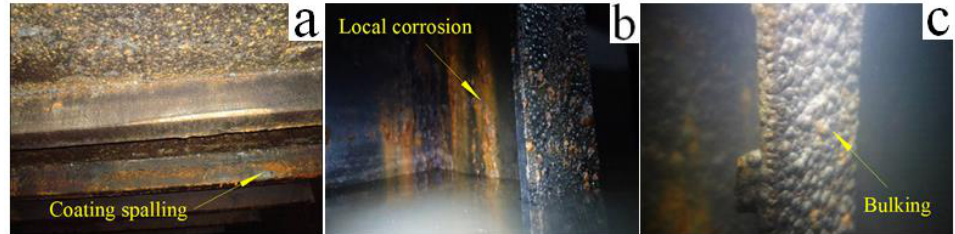
Figure 2. Typical images of corrosion states within the protective device of ( a ) the spray zone, ( b ) the tidal zone and ( c ) the full immersion zone.